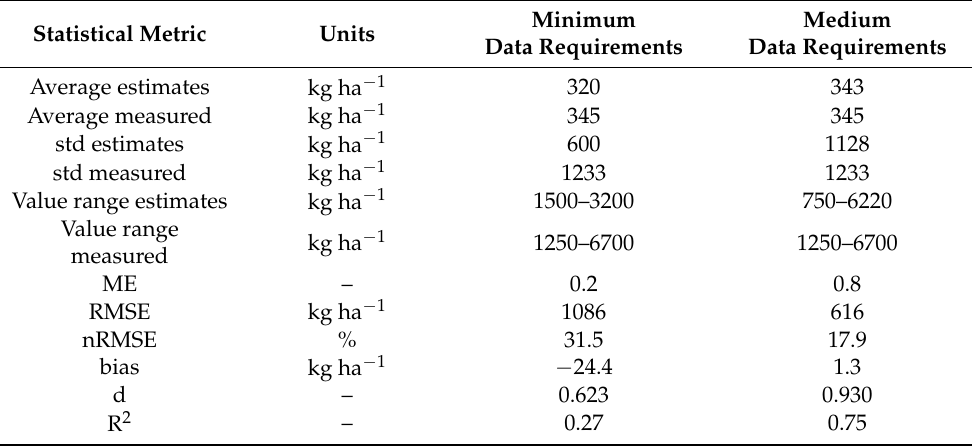
Table 6. Statistical evaluation of yield estimates with AquaCrop only for rainfed parcels (n = 127). Statistical Metric Units